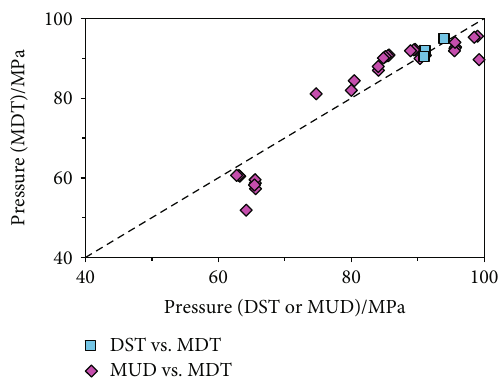
Figure 3: Comparison of pore pressures from di ff erent data source. The measured pressure is from the DST and MDT, and MUD means the equivalent pressures calculated from mud